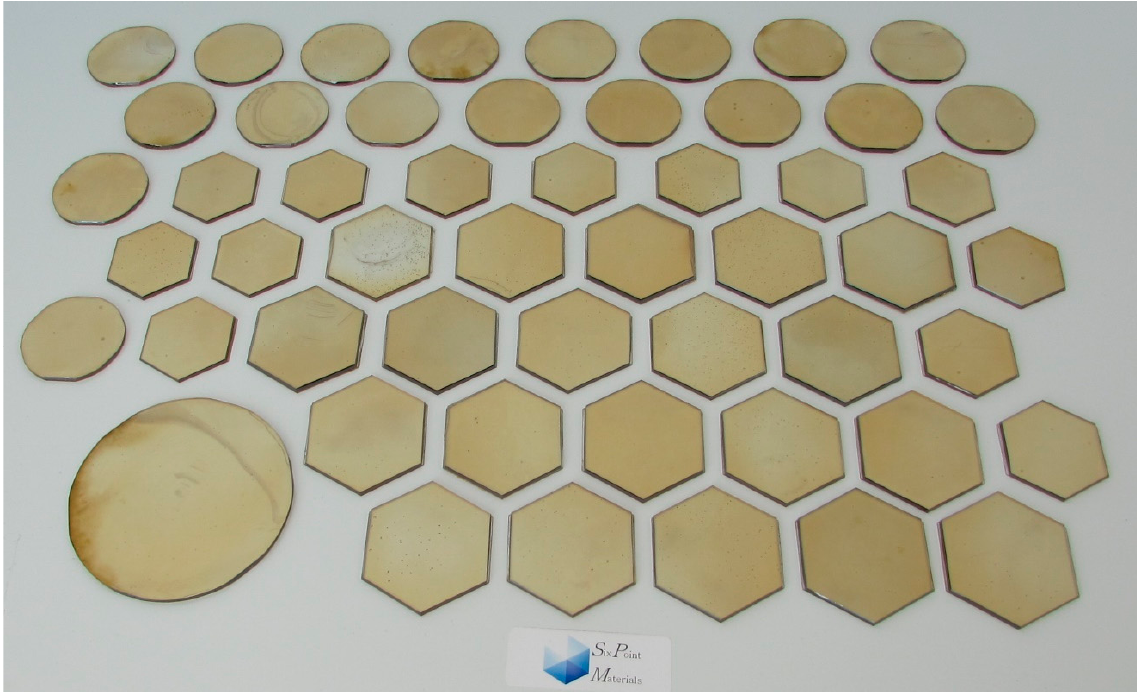
Figure 1. A photograph of bulk GaN crystals grown in one batch. The largest round crystal is approximately 100 mm in diameter and the other round crystals have approximately 50 mm in diameter. The larger hexagonal crystals have a side-to-side width of approximately 50 mm and the smaller hexagonal crystals have a point-to-point width of approximately 50 mm.